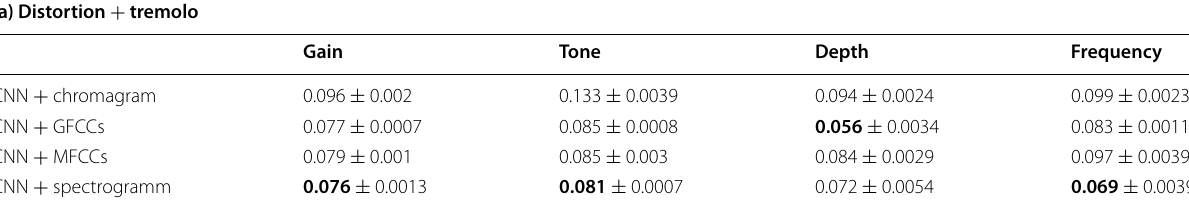
Table 5 95% confidence intervals of the mean absolute error of the CNN across the fivefold cross-validation of the parameter extraction and all volumes. Results are reported for all time-frequency representations and the combination of distortion and tremolo